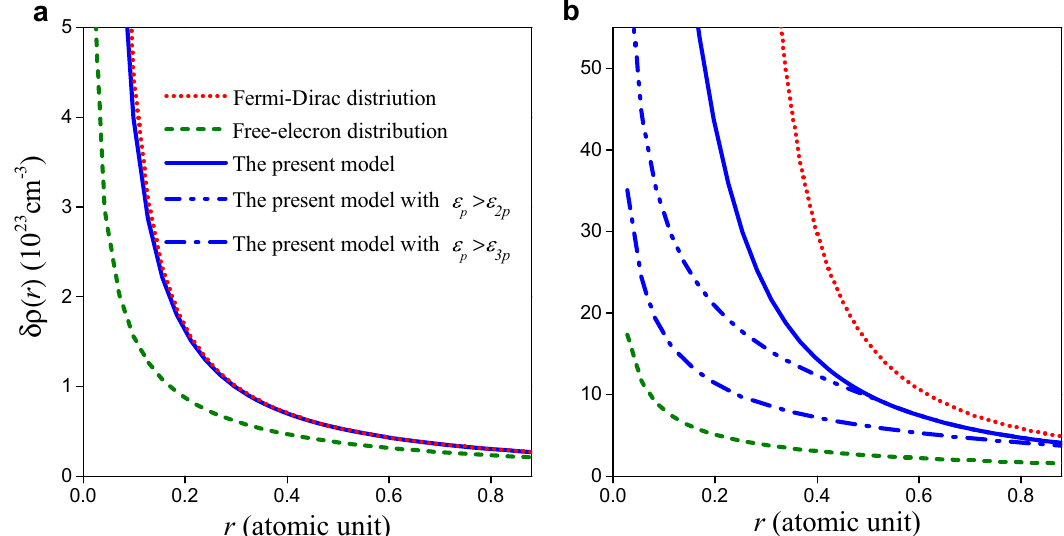
Fig. 3 Electron density fl uctuations of ion embedded in hot dense plasma. a , b Electron density fl uctuations δρ ð r Þ versus r obtained from the present model and other models for the charge state numbers of a Q = 1 and b Q = 11 (Al 11 + ). The mean electron density ρ T r ranges from 0 to a = 2 (cid:5) 0 : 88. Electron densities from Fermi – Dirac distribution (dash line), linear Debye – Hückel model (dot e is 300 eV. The distance WS line) and the present model (solid line) are shown in panels a and b . In panel b , the present model with the condition of ε dash – dot – dot line and dash-dot line, respectively. Here, ε p is the energy of recombined electron, ε 2 p and ε 3 p are the orbital energies of 2 p and 3 p , which are about − 498 and − 217 eV,